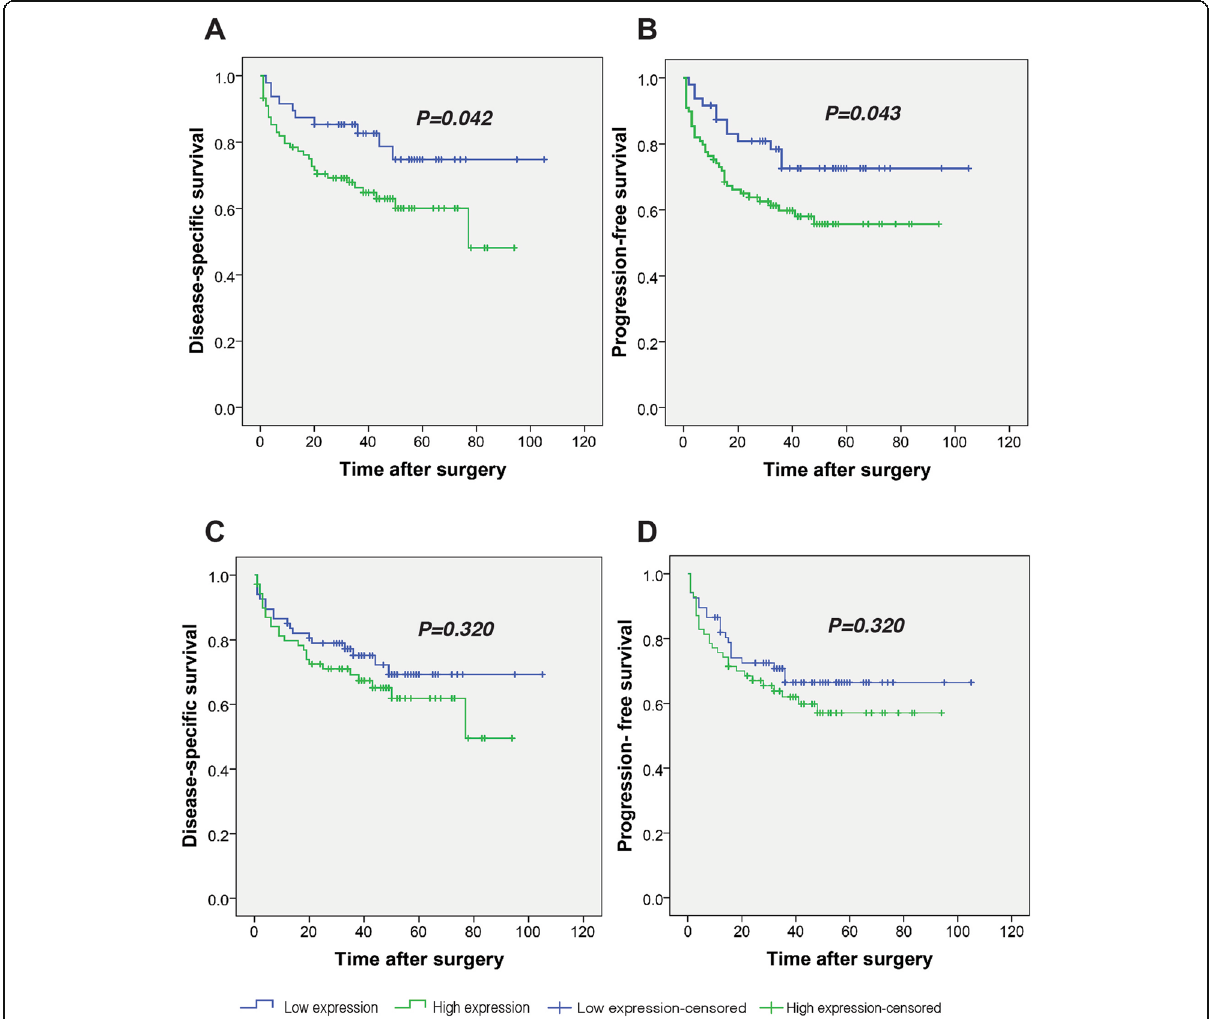
Fig. 4 Kaplan-Meier curves for disease-specific survival (DSS) and progression-free survival (PFS) according to the expression levels of TWIST1 in colorectal cancer. (Nuclear and cytoplasmic TWIST1 expression in tumor cells was divided into two groups as follows: high and low expression levels). a Log Rank test showed that patients with a high nuclear TWIST1 expression had shorter DSS and b PFS compared to patients with a low nuclear TWIST1 expression ( P = 0.042 and P = 0.043, respectively). c, d The Kaplan – Meier survival analysis showed that there were no significant differences in terms of survival (DSS and PFS) between patients with high and low cytoplasmic TWIST1 expressions (Survival analysis: DSS ( P = 0.320) and PFS ( P =